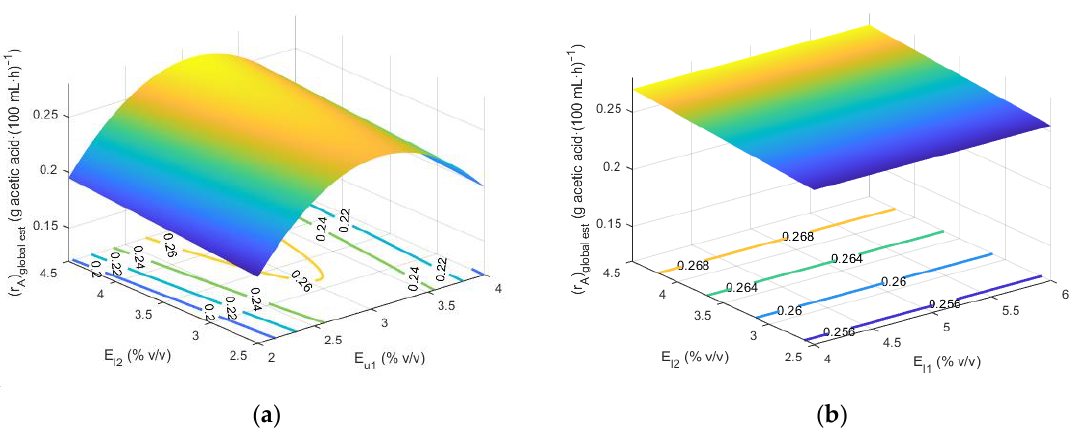
Figure 3. Response surfaces of (𝑟 𝐴 ) 𝑔𝑙𝑜𝑏𝑎𝑙 𝑒𝑠𝑡 varying 𝐸 𝑢1 and 𝐸 𝑙2 ( a ) as well as 𝐸 𝑙1 and 𝐸 𝑙2 ( b ), using values from Table 2 for the remaining operational variables.